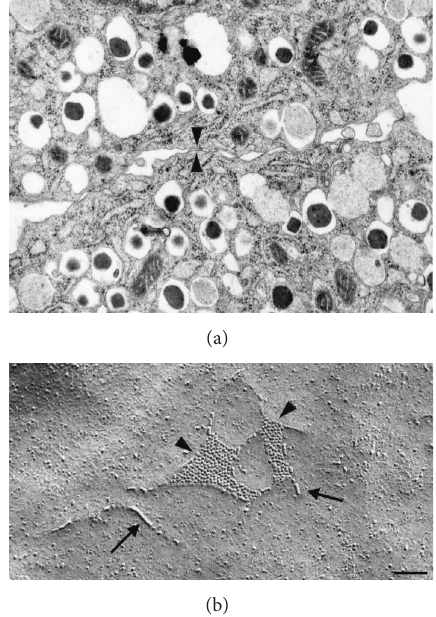
F 5: Cx36 mediates the direct coupling of the insulin- producing -cells. (a): transmission electron microscopy shows that the membranes of adjacent -cells, identi�ed by their content in typical insulin-containing granules, are usually separated by an 𝛽𝛽 electronlucent extracellular space, which is markedly narrowed at 𝛽𝛽 a gap junction plaque (arrow heads). (b): freeze-fracture electron microscopy of such a site reveals clusters of Cx36 channels (arrow heads) within the bilayer of a -cell membrane. e arrows point to short tight junction �brils, which are closely associated to the connexons. Bar: 250nm in (a), and 120nm in 𝛽𝛽